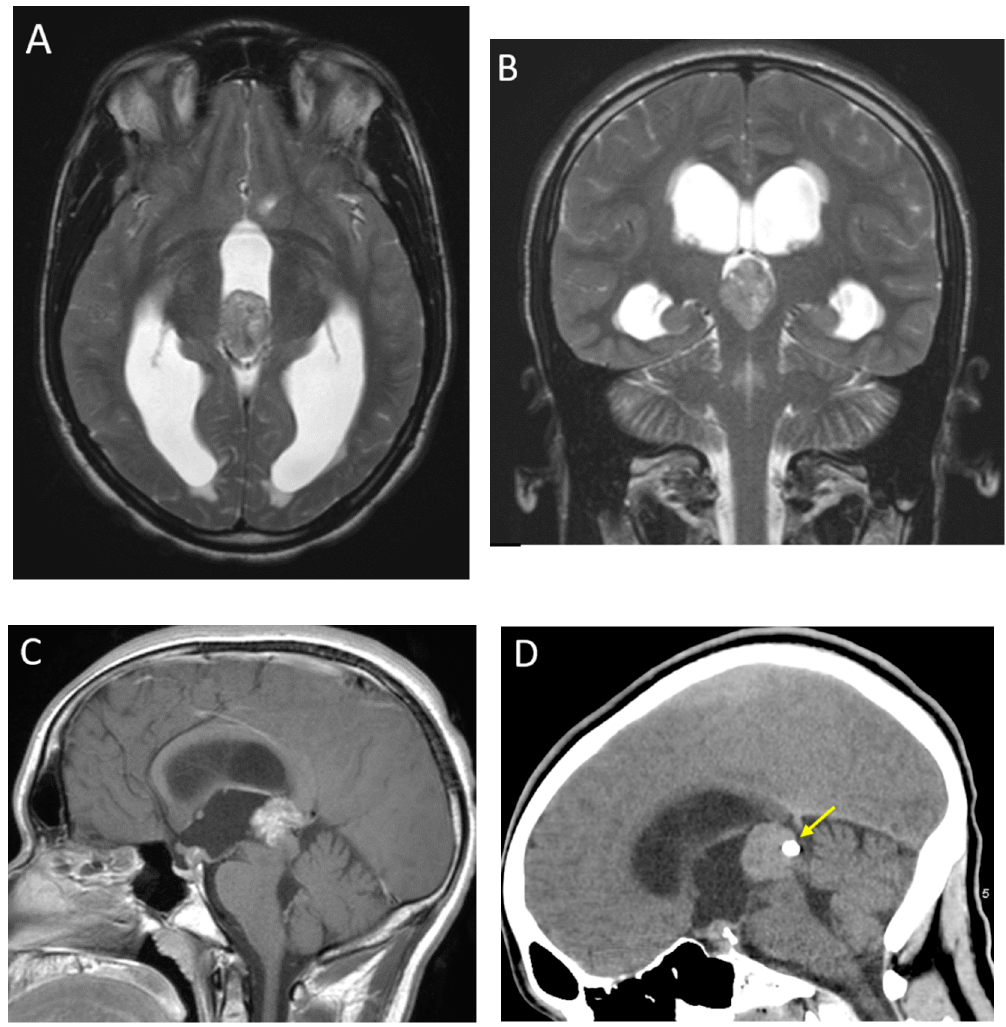
Figure 12. A 19-month-old male with with germ cell tumor and synchronous involvement of the pineal and suprasellar regions. Axial and coronal T2-weighted ( A , B ) images of the pineal region demonstrate heterogeneously T2-isointense mass with obstructive hydrocephalus. Sagittal post- contrast T1-weighted image ( C ) demonstrates heterogenous enhancement of the pineal region mass with obstruction of the cerebral aqueduct, and also a smaller, similar-appearing mass, involving the pituitary infundibulum (arrowhead). Sagittal non-contrast CT image ( D ) of the same patient demonstrates a rounded pineal calcification ‘engulfed’ by the mass (arrow), which can help to distinguish germ cell tumors from